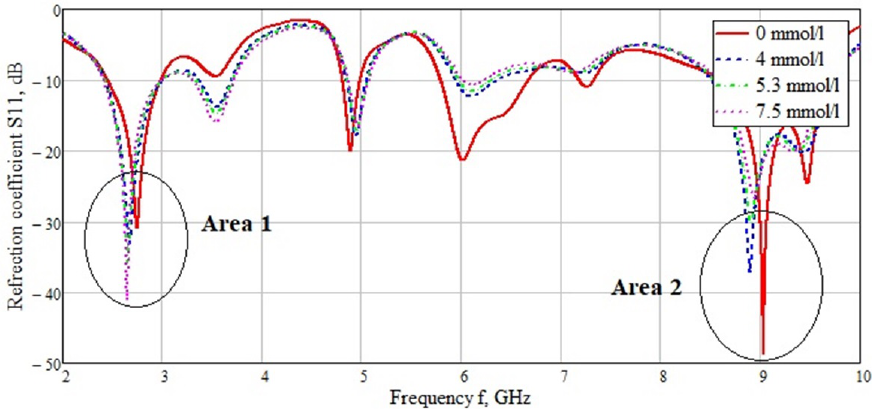
Figure 7. Frequency response of the reflected signal for various glucose concentrations.